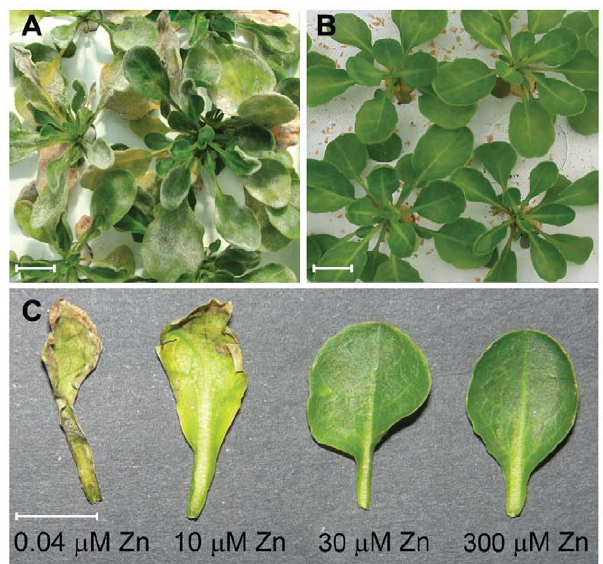
Figure 1. High zinc concentrations suppress disease symptoms in Thlaspicaerulescens . A . T. caerulescens plants growing on 10 m M zinc during an outbreak of mildew ( Erysiphe sp.) in the glasshouse. B . T. caerulescens plants growing on 300 m M zinc during the same outbreak of mildew in the glasshouse. C . T. caerulescens plants were grown for 10 weeks on nutrient solution containing 0.04, 10, 30, or 300 m M ZnSO 4 . Leaves were infiltrated with P. syringae pv. maculicola M4 suspended in 10 mM MgCl 2 at 10 8 cfu/ml and photographed 96 hours after inoculation. Scale bars represent 10 mm.